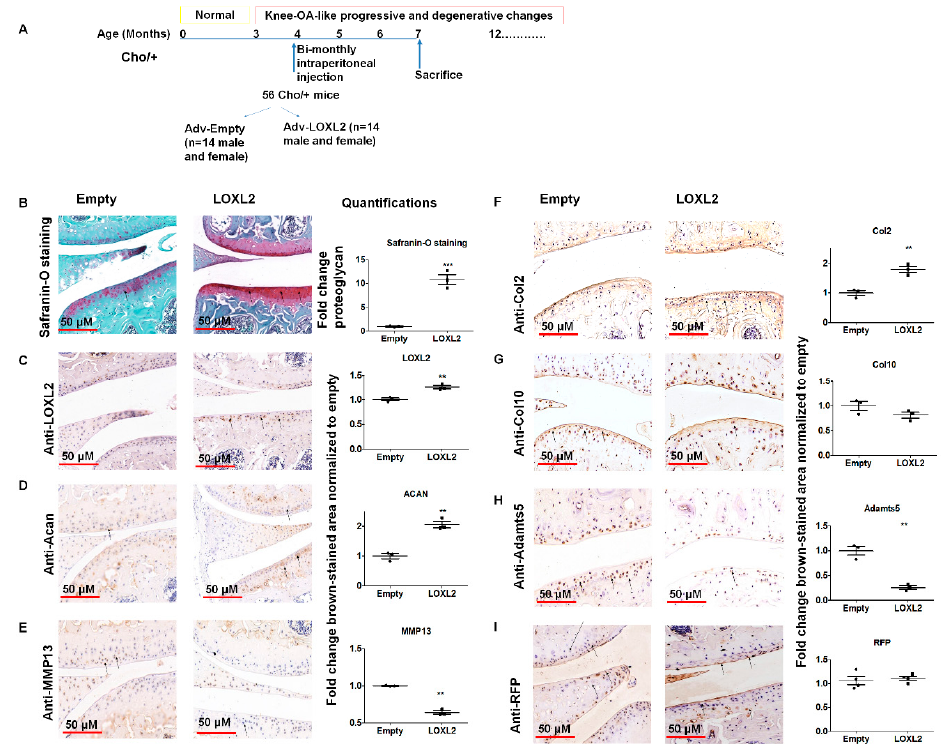
Figure 1. LOXL2 induces a protective response in Cho /+ mice knee joint articular cartilage. ( A ) Scheme of experimental groups and the treatment. ( B ) Safranin-O / Fast green staining of TMJ condylar cartilage in Adv-RFP-Empty compared to Adv-RFP-LOXL2 adenovirus-injected mice, quantification. Immunostaining and quantification of ( C ) LOXL2; ( D ) Acan; ( E ) MMP13; ( F ) Col2; ( G ) Col10; ( H ) Adamts5 and ( I ) RFP in Adv-RFP-Empty and Adv-RFP-LOXL2 treated mice. The statistically